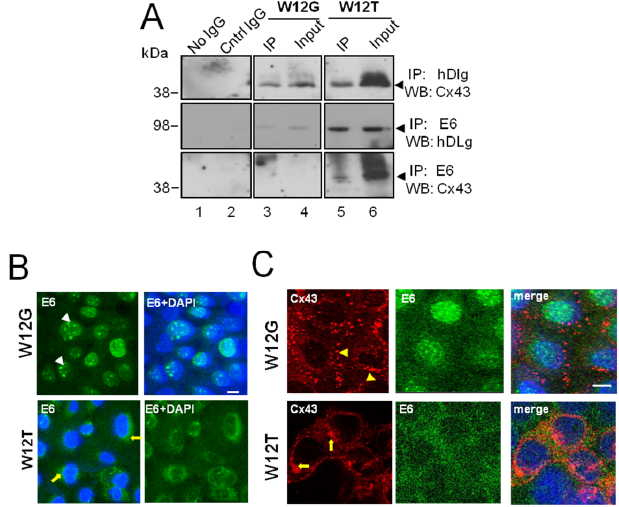
Figure 2. HPV16 E6 associates with Cx43 in W12T cervical cancer cells. ( A ) Co-immunoprecipitation of E6 with hDlg and Cx43 in W12G non-tumour and W12T tumour cells. Antibodies used in immunoprecipitation (IP) and the antibodies used to probe western blots (WB) are indicated on the right hand side. No IgG, beads alone used in the immunoprecipitation. Cntr IgG, a matched antibody isotype negative control immunoprecipitation. Input, 10% of the volume of cellular extract as used in the co-immunoprecipitation experiments; ( B ) Confocal immunofluorescence microscopy imaging showing E6 (green) in the nucleus of W12G cells (arrowheads) but in the cytoplasm of W12T cells (arrows); ( C ) Confocal immunofluorescence microscopy imaging of Cx43 (red) in W12G cells located in large punctuate gap junction plaques (arrowheads) on the membrane. In W12T cells membrane Cx43 (red) is reduced and some perinuclear staining is detected (arrows). E6 is shown in green. Nuclei are stained with DAPI (blue). Bar = 10 μ M.